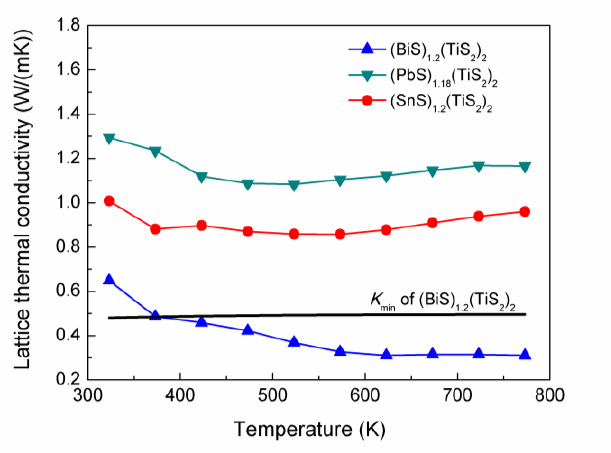
(TiS ) is also 1.2 2 2